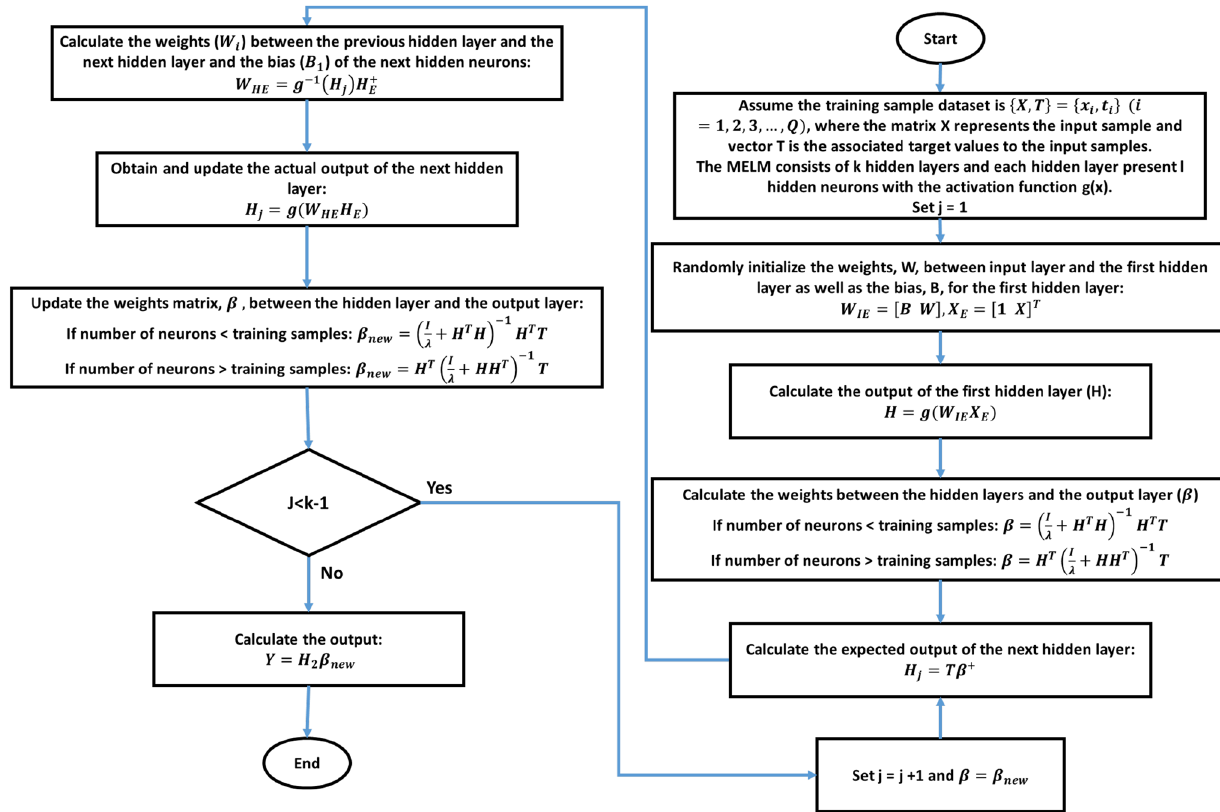
Fig. 18 Flowchart of MELM algorithm (the + sign in the superscript refers to generalized inverse